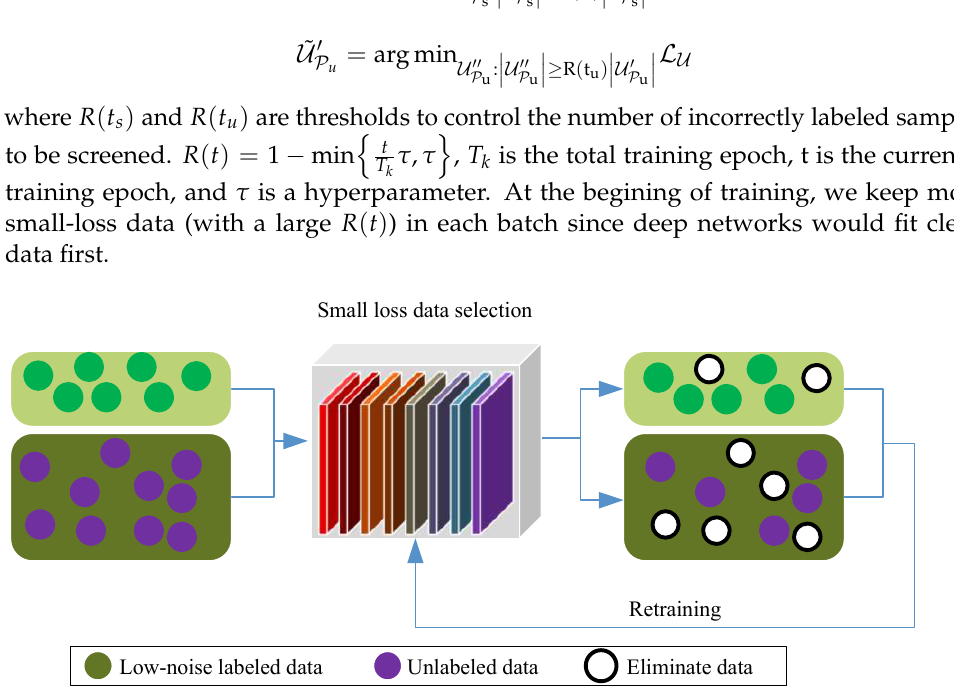
Figure 4. Framework of the retraining and small loss